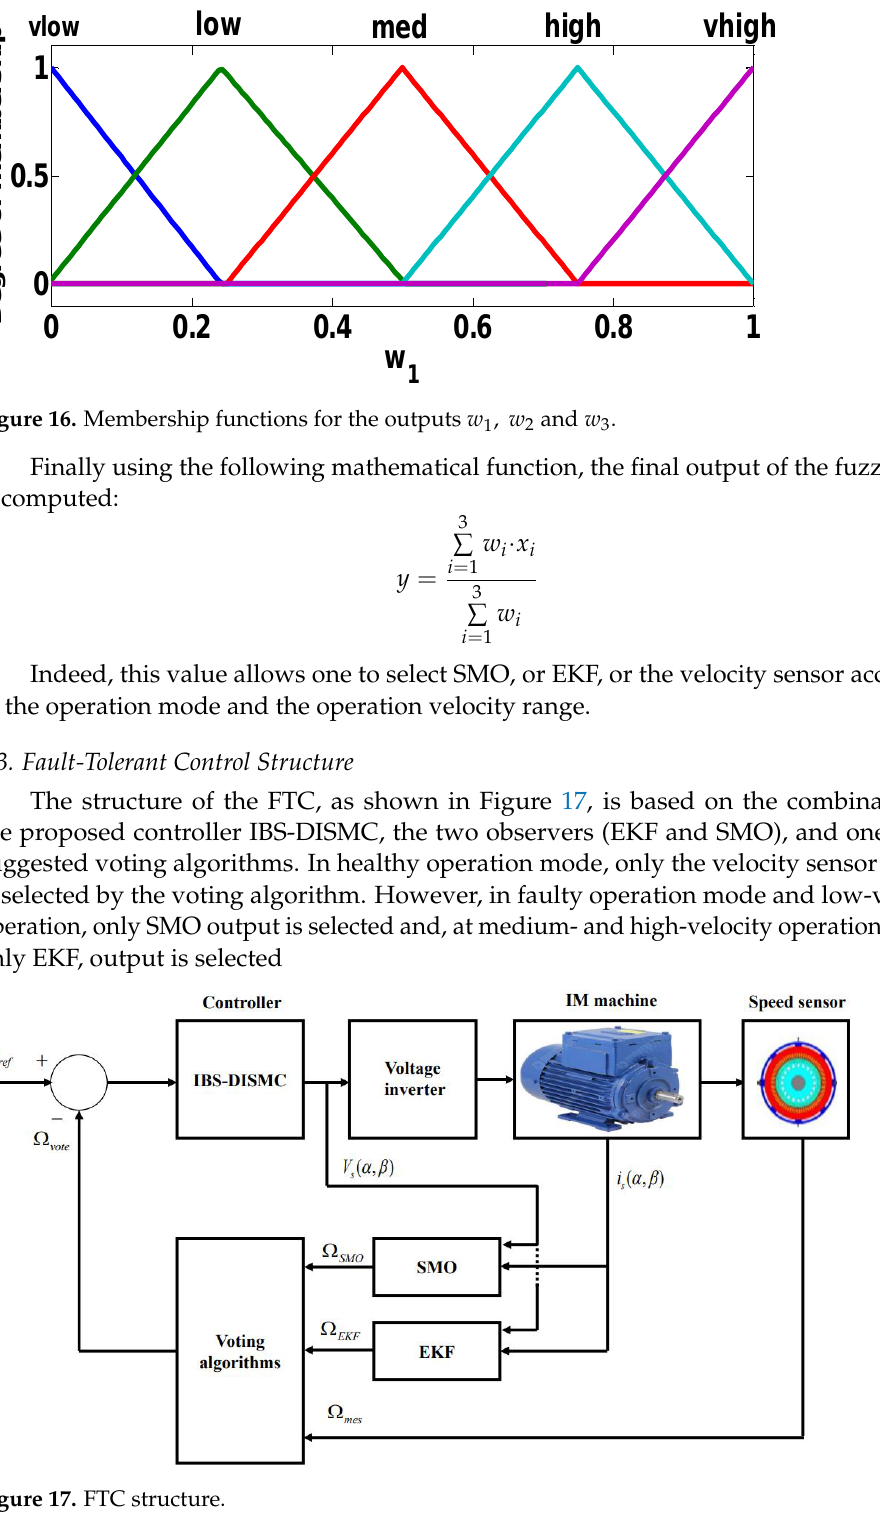
Figure 15. Membership functions for the distance 𝑑 23 .